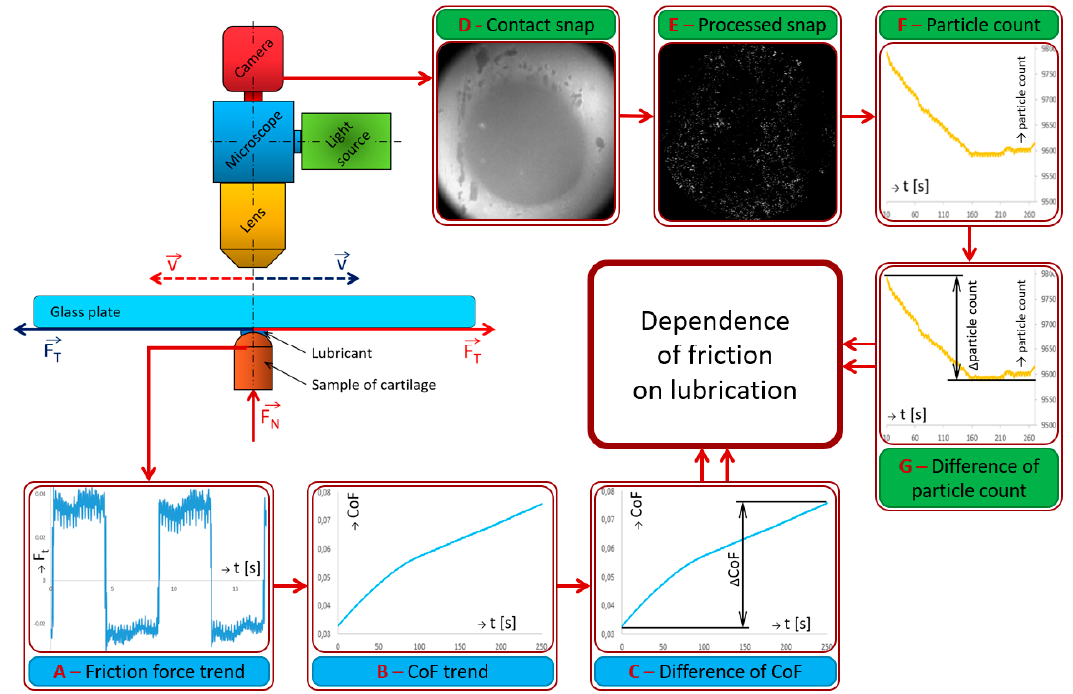
Figure 6. Evaluation schema. ( A ) Friction force trend ( B ) CoF trend ( C ) Difference of CoF ( D ): Contact snap ( E ) Processed snap ( F ) Particle count ( G ) Difference of particle count.